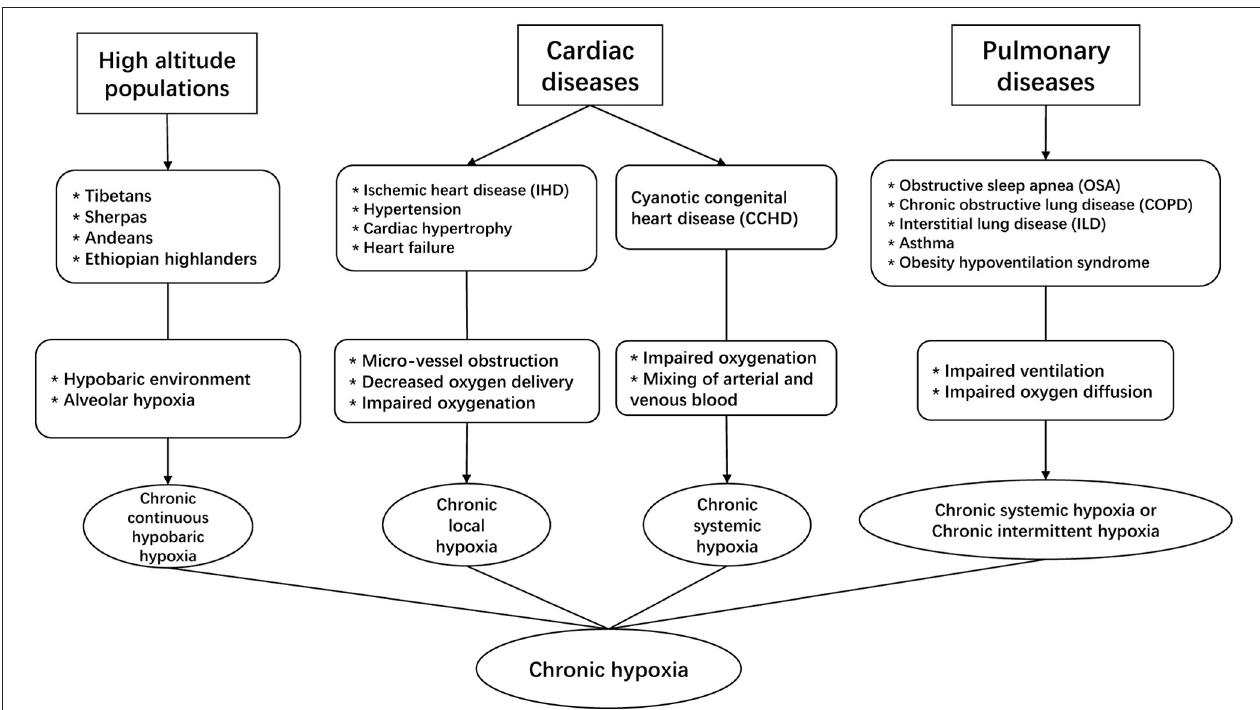
FIGURE 1 | The involvement of chronic hypoxia in different clinical